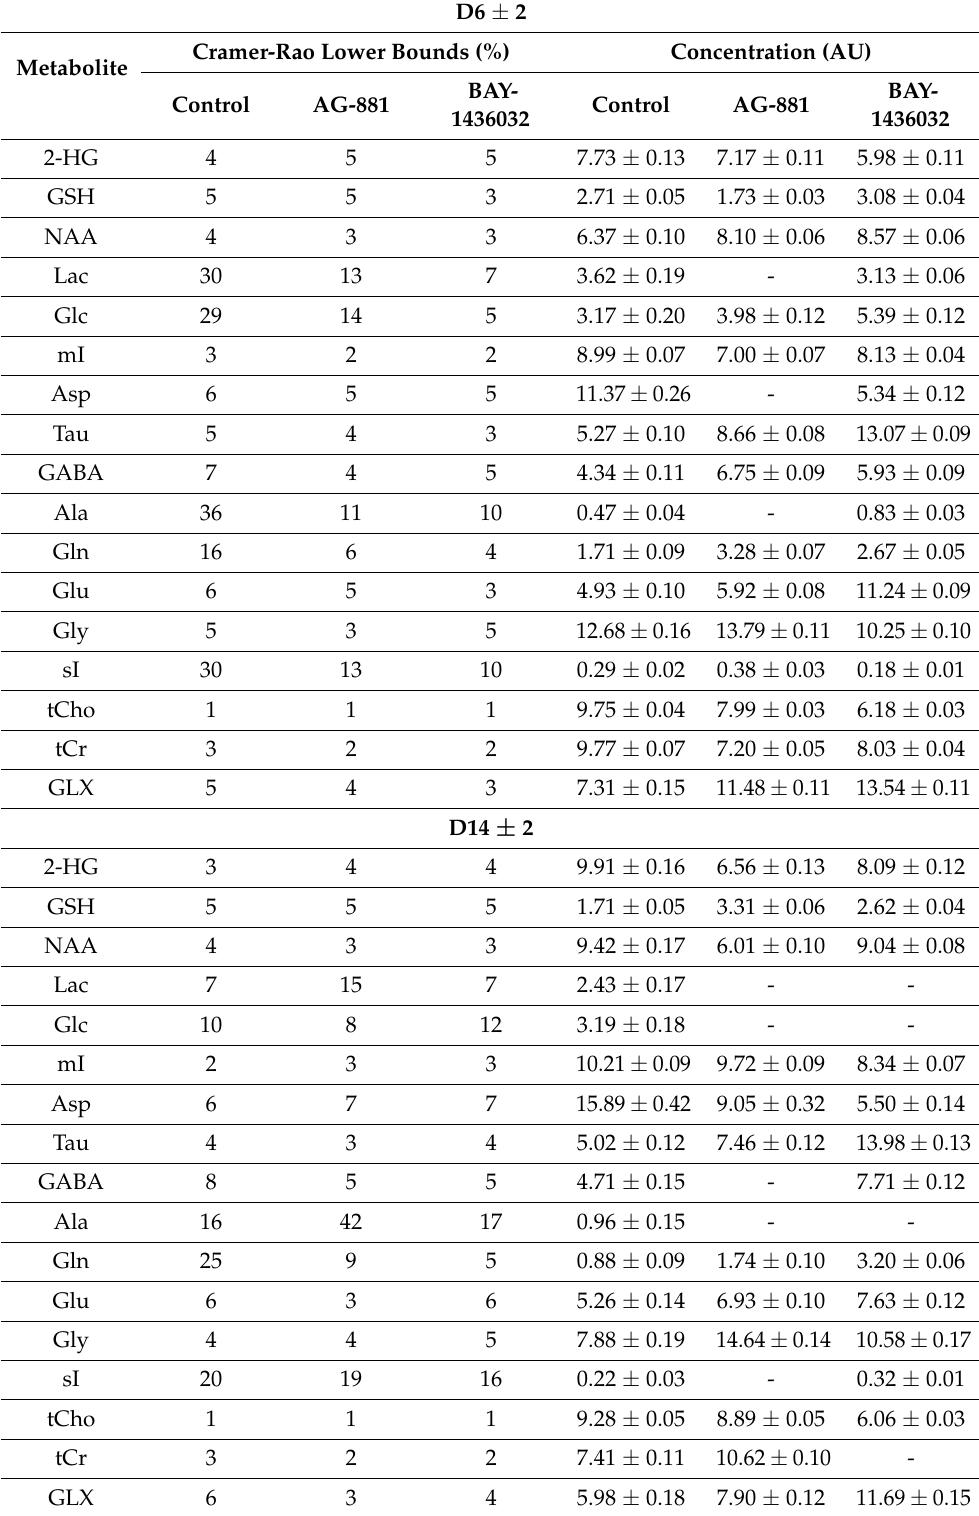
Table 3. Metabolite levels significantly different between control and treated SF10417 tumors at early (D6 ± 2) and late (D14 ± 2) time